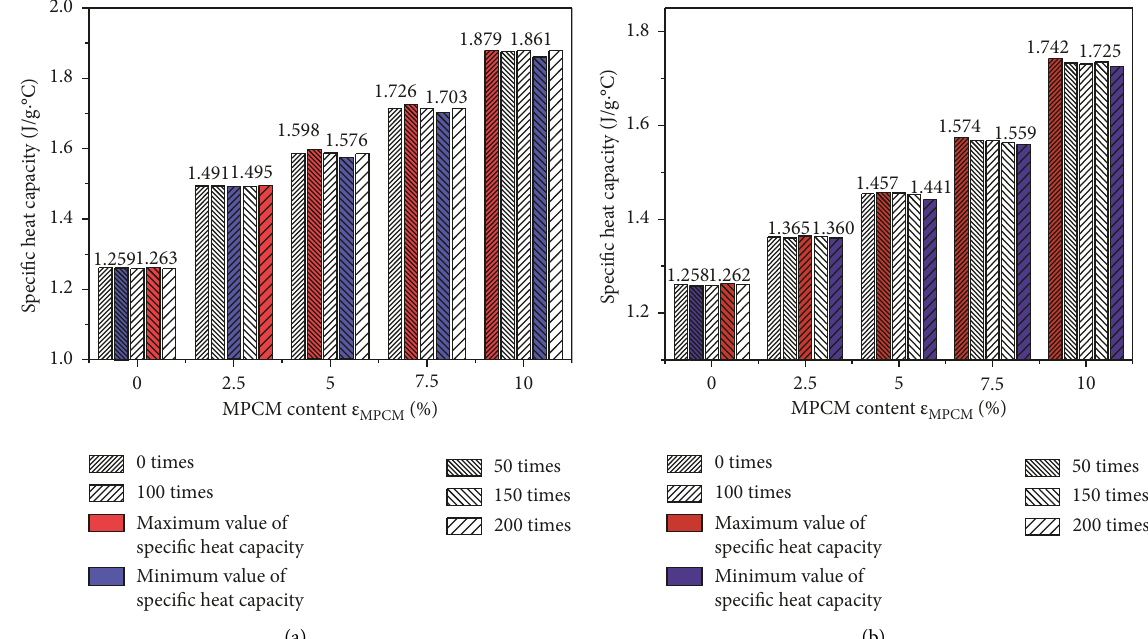
Figure 13: Effect of the phase-change cycle numbers on the specific heat capacity of MPCM-LWAC. (a) Heat absorption by melting. (b) Heat release by curing.